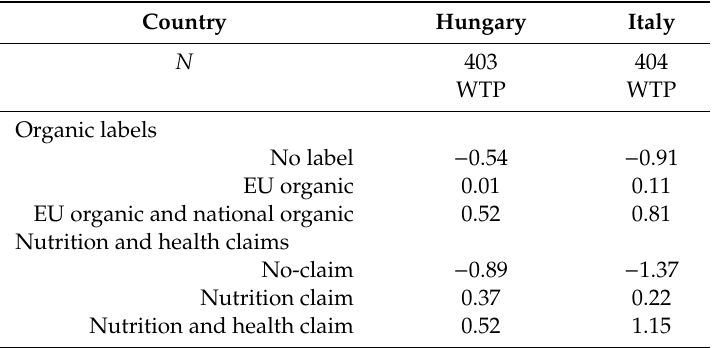
Table A1. WTPs derived based on the RPL